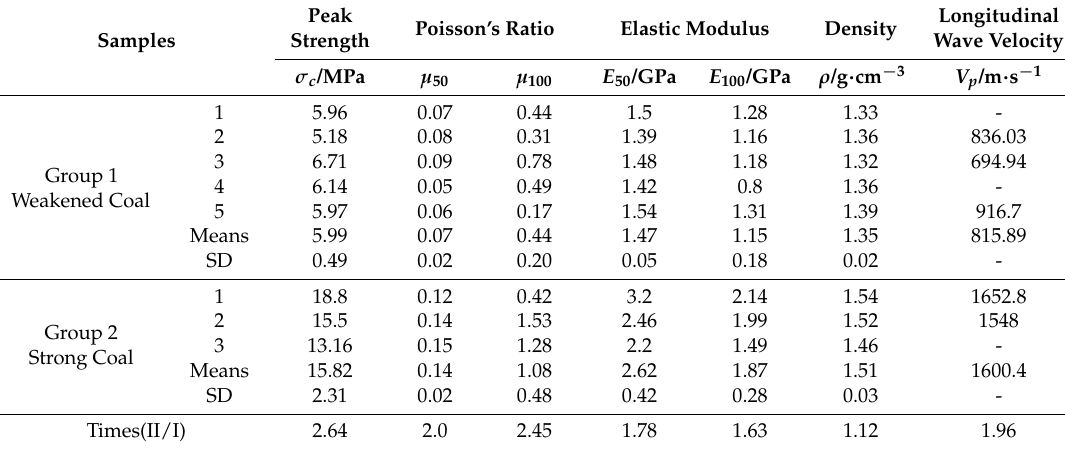
Table 1. Results of intact coal under uniaxial